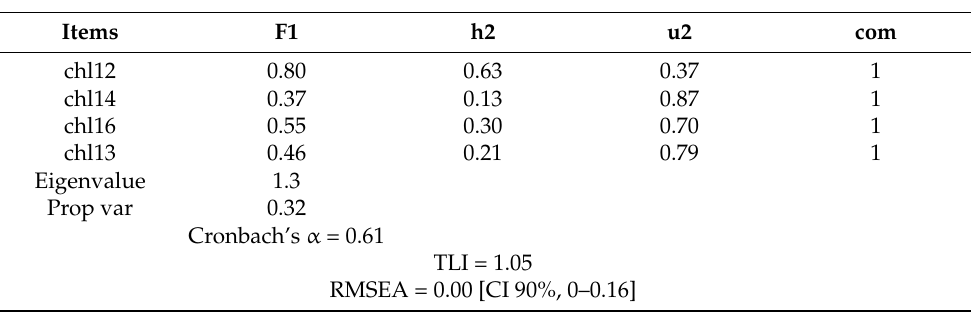
Table 2. Exploratory factor analysis of scale B. Factor loadings < 0.30 are suppressed. h2 = commu- nality (amount of variance explained by common factors). u2 = residual variance (variance unique to the variable). com = indicator of